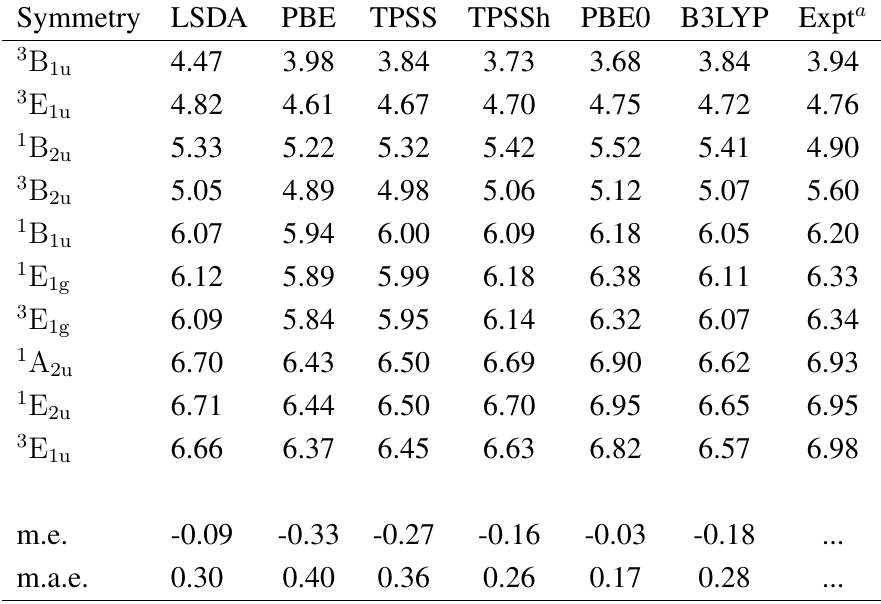
Table 8. The same as Table 2, but for benzene (C 5.89